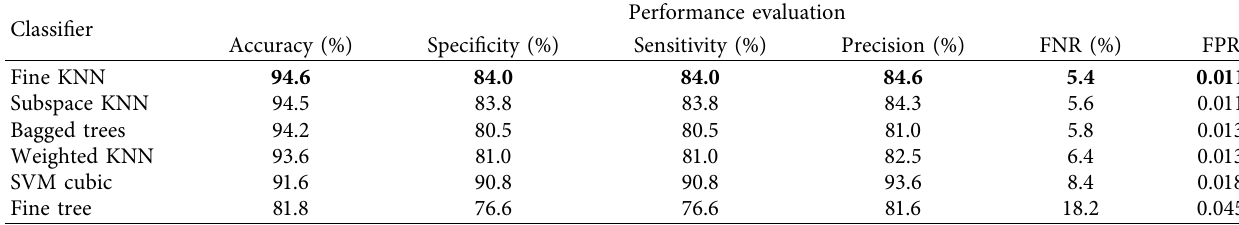
Table 5: Performance evaluation of experiment 2.